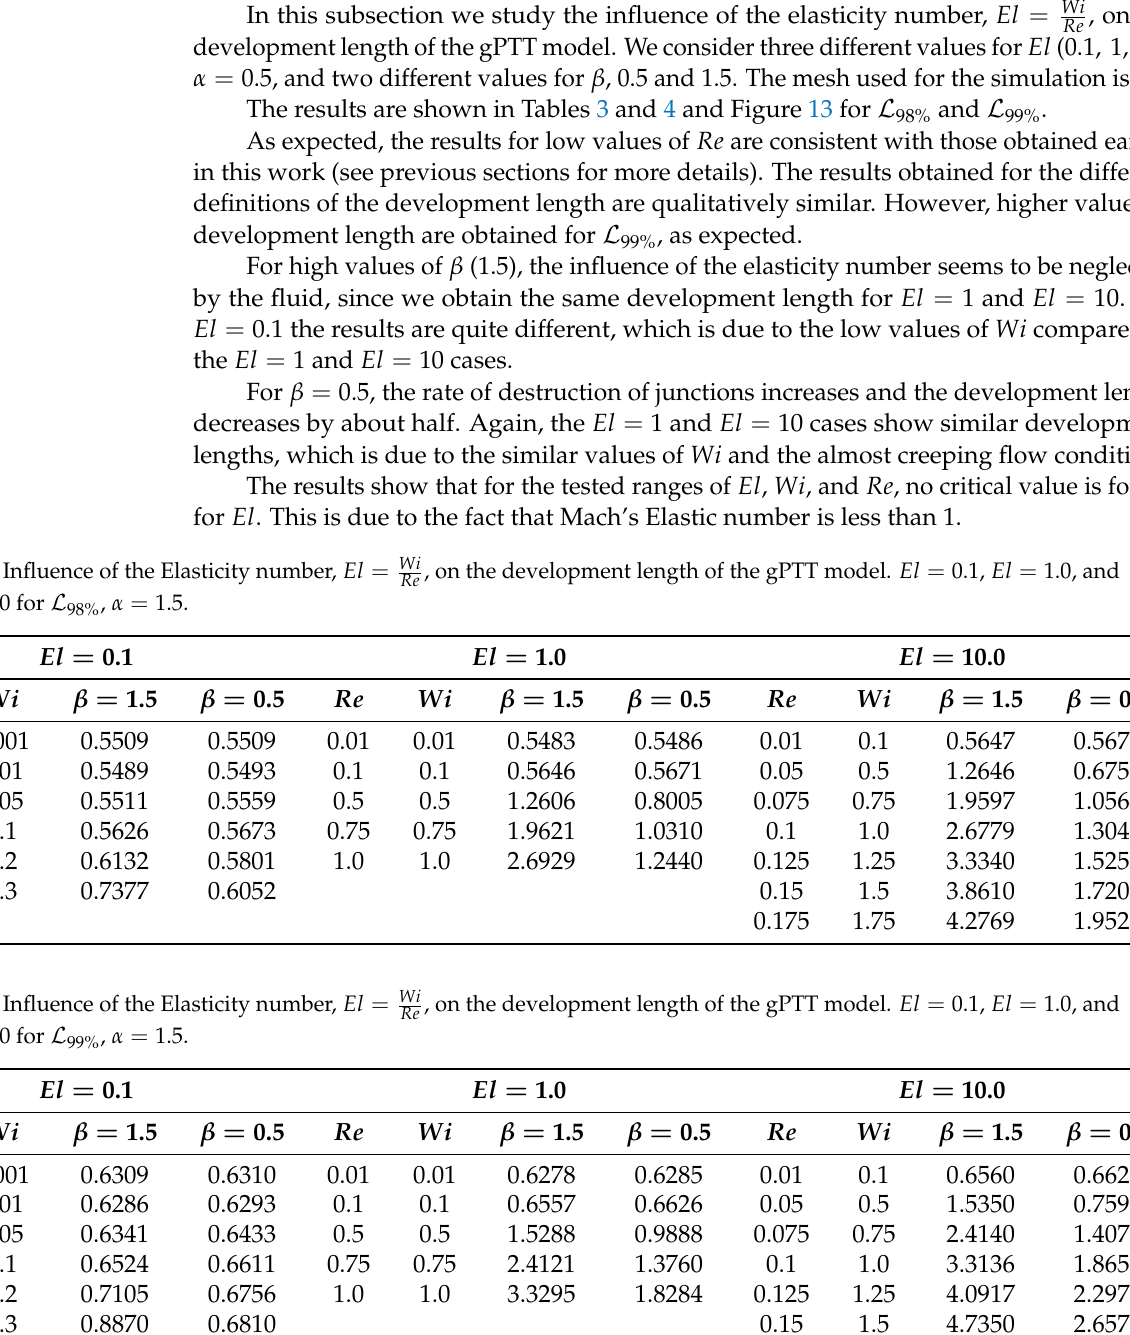
, on the development length of the gPTT model. El = 0.1, El = 1.0, and Re